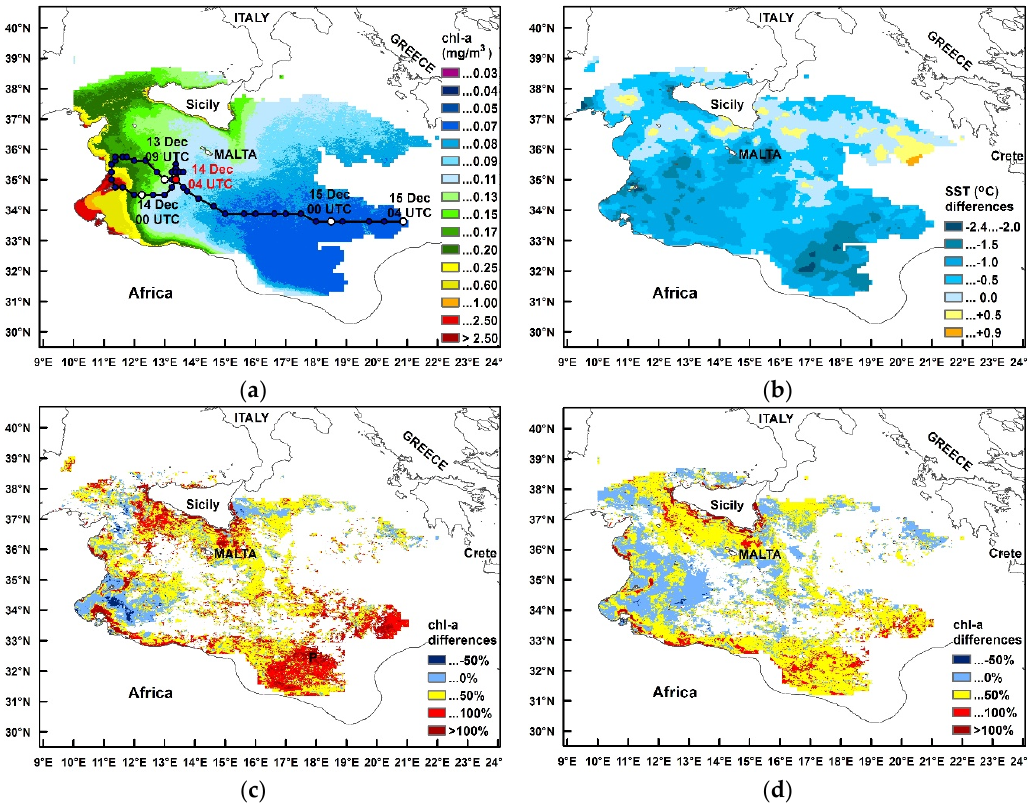
Figure 1. ( a ) The study area together with the mean 1998–2016 chlorophyll-a concentration for December and the medicane’s track. Day and hour refer to the white dots while the red dot denotes the minimum pressure; ( b ) Sea surface temperature (SST) differences between 11 and 17